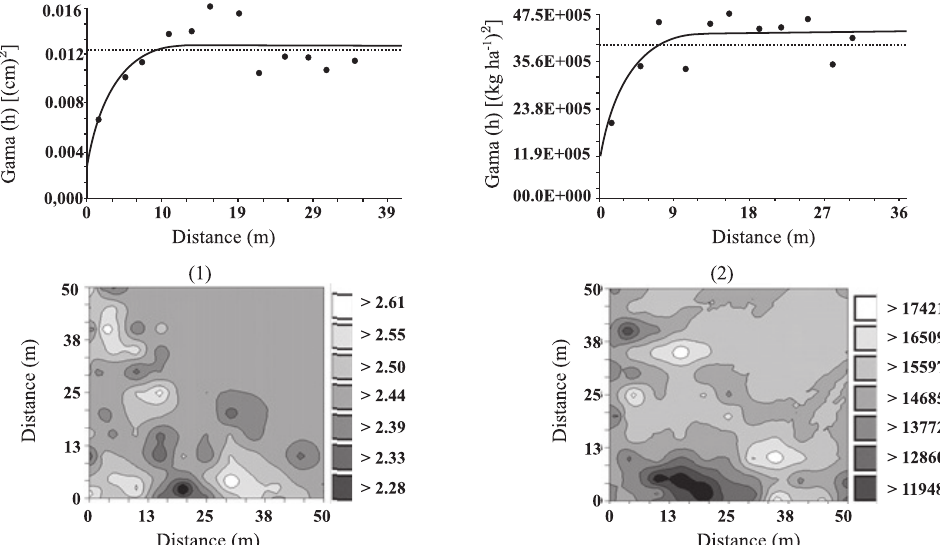
Figure 1. adjusted semivariogram and kriging maps of the properties of corn forage productivity: (1) FdM and